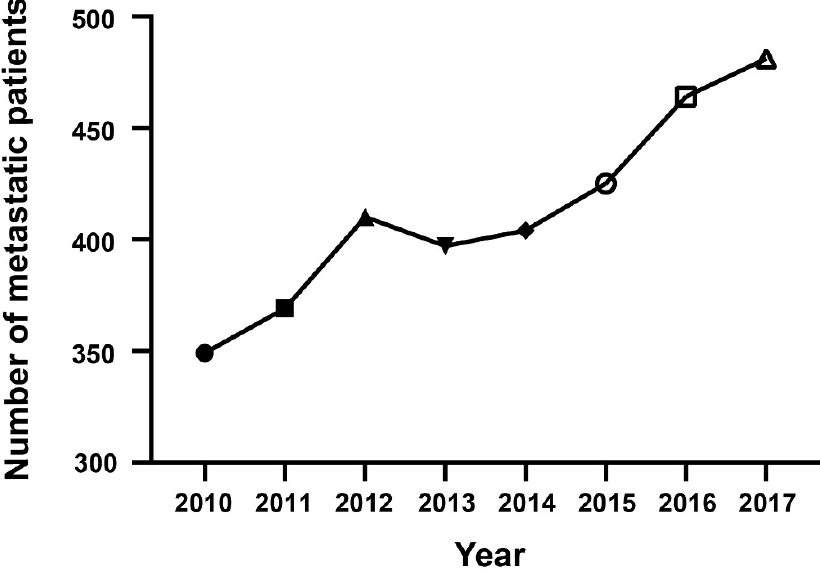
Figure 2. The epidemiological trend for the annual number of mPDAC patients.